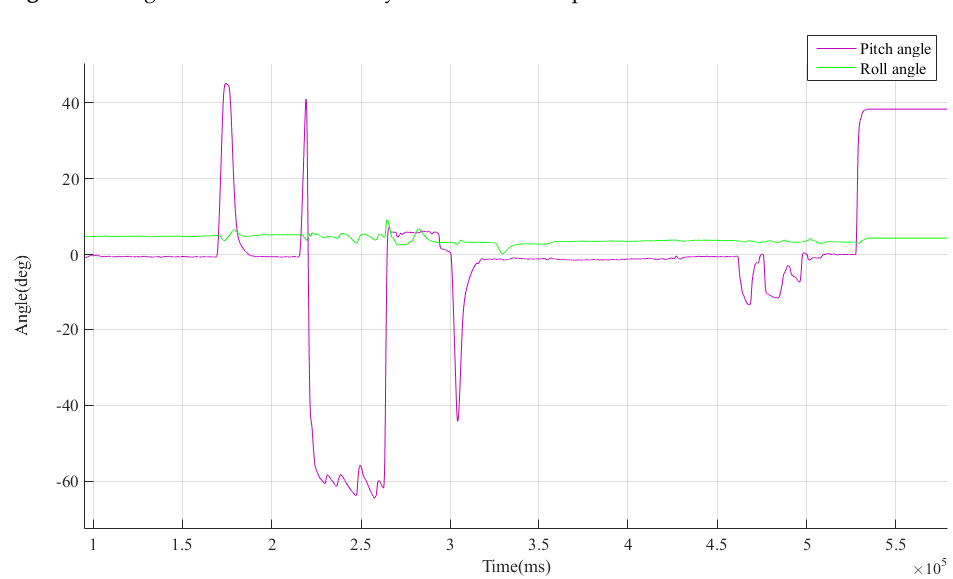
Figure 11. Angles issued by the carrier to the pod during the first simulated autonomous flight.